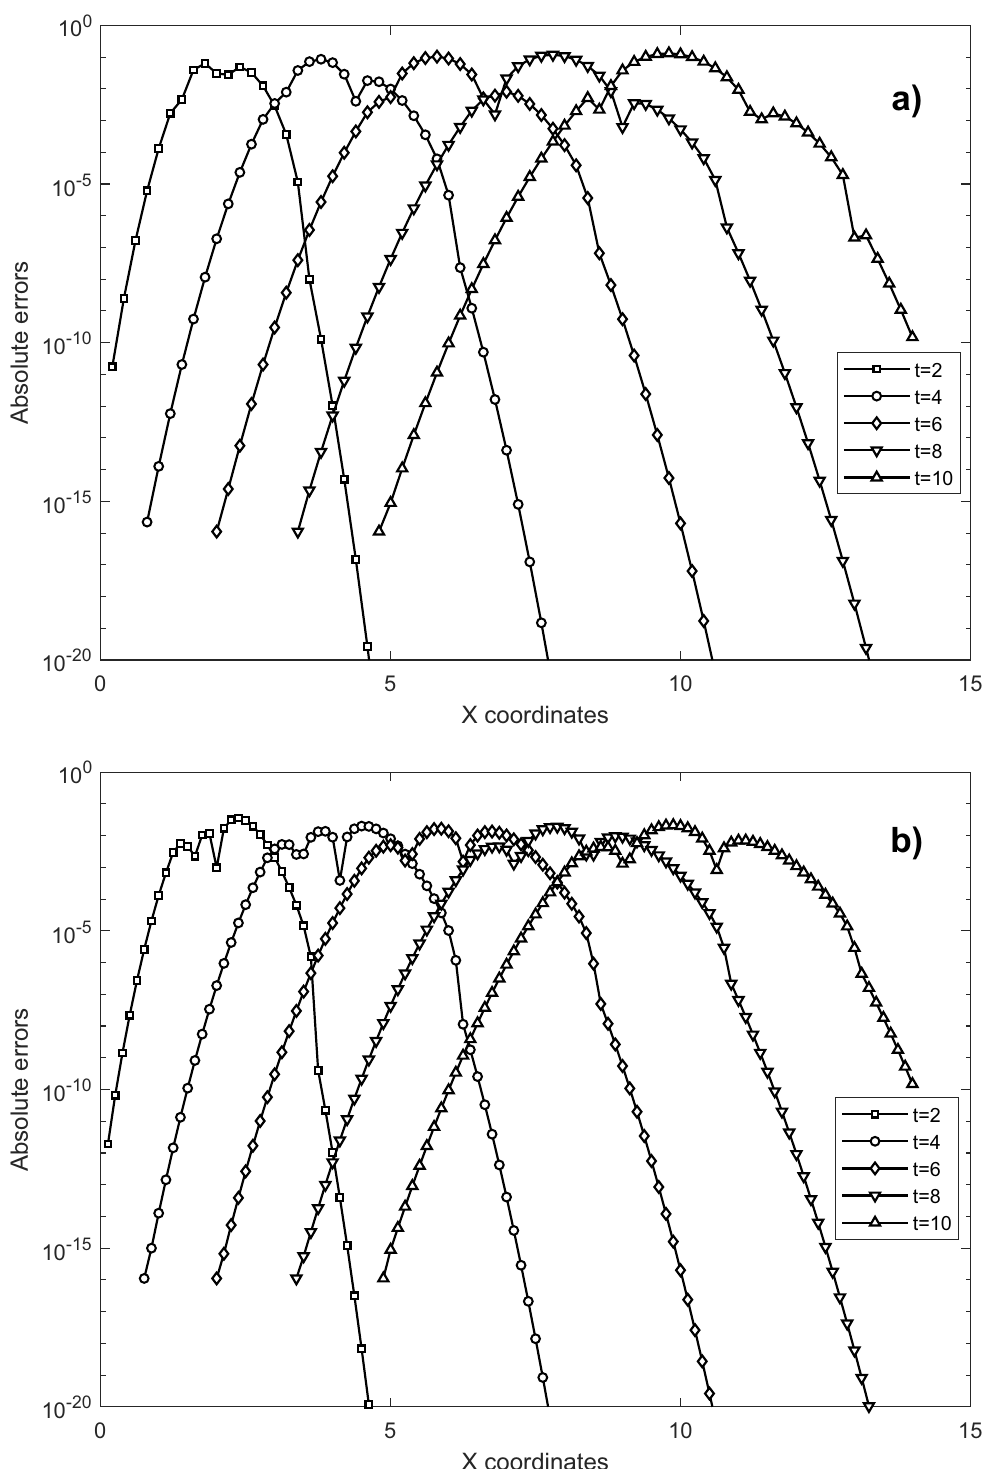
Figure 11. Example No. 3—absolute errors for Pe = 1000, ( a ) Grid 101 × 11, ( b ) Grid 161 × 17. Table 8 clearly shows that the values of RMSE and R ∞ decrease when increasing the density of the